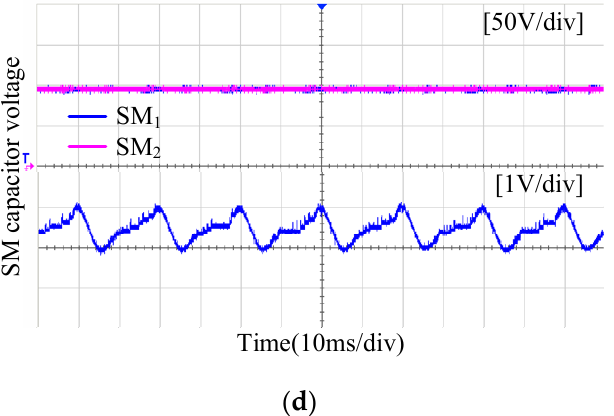
Figure 12. Experimental results with type u fault ( a ) phase u voltage ( b ) line voltage u uv ( c ) current of phase u ( d ) some SM capacitor voltages of phase u and one zoomed-in curve.